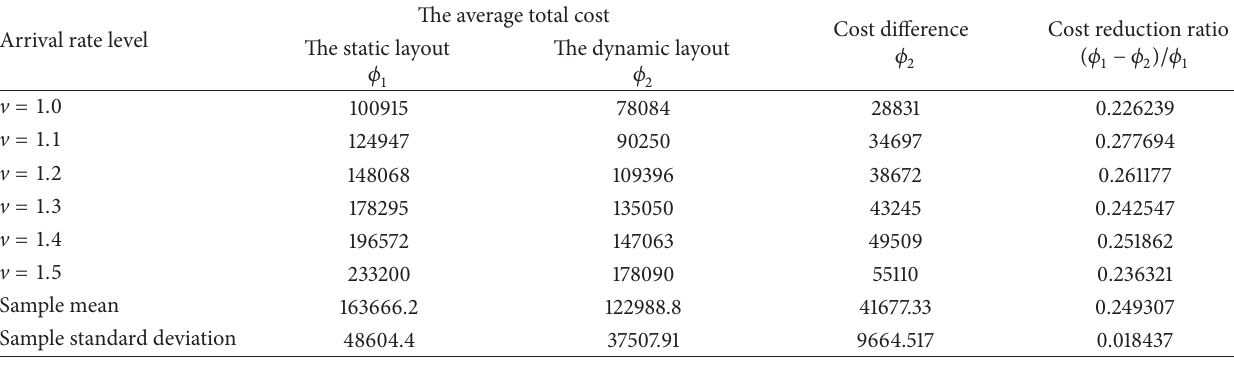
Table 3: Comparison of the average total cost of two cases.